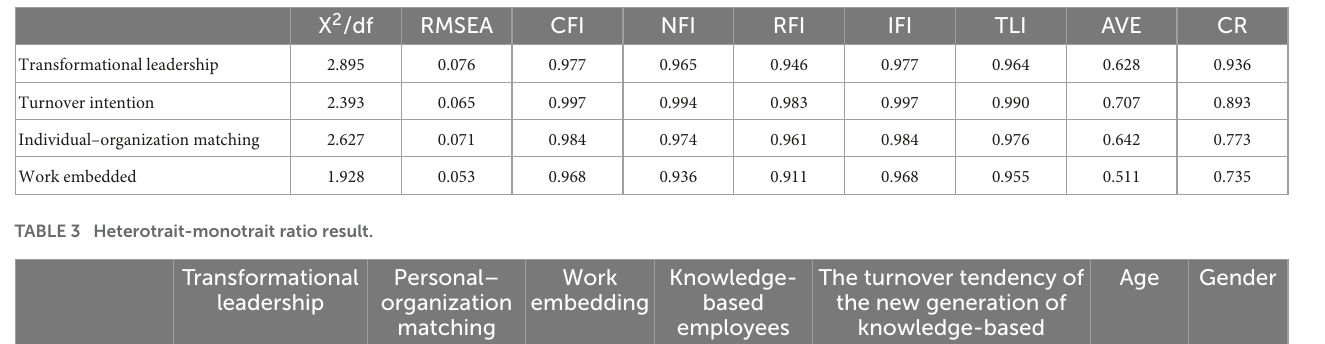
TABLE 2 Confirmatory factor analysis results ( N = 326).